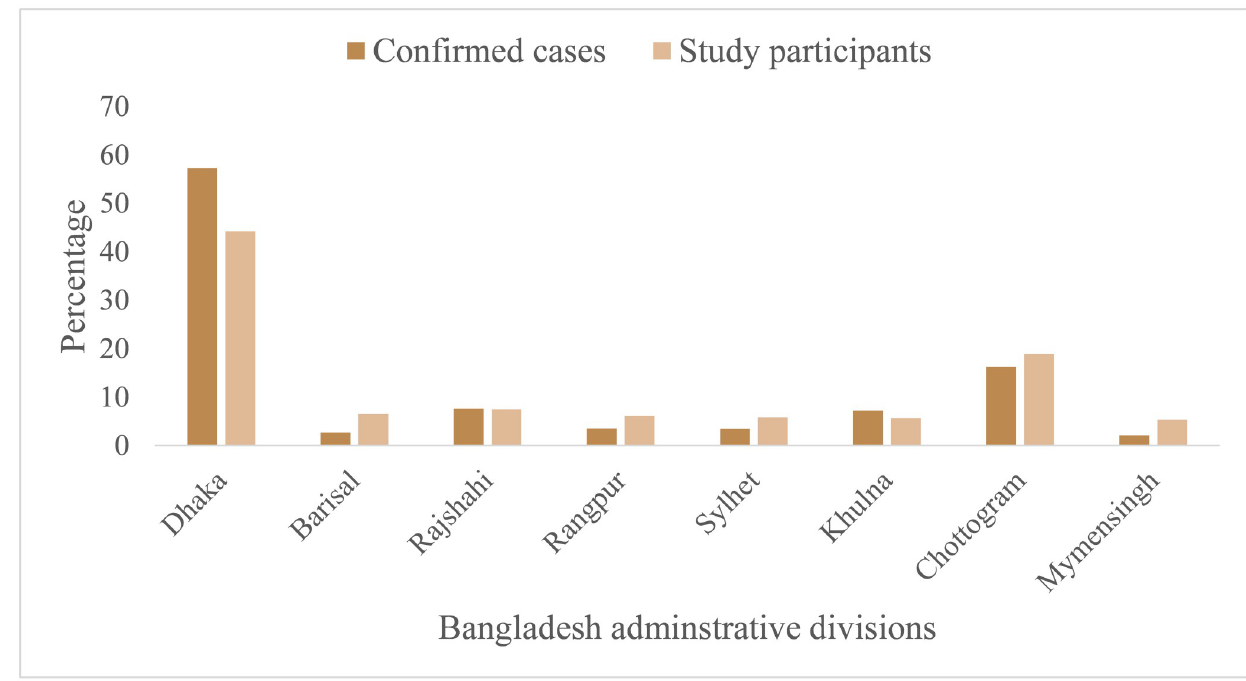
Fig 1. The proportion of confirmed COVID-19 cases and study participants across eight administrative